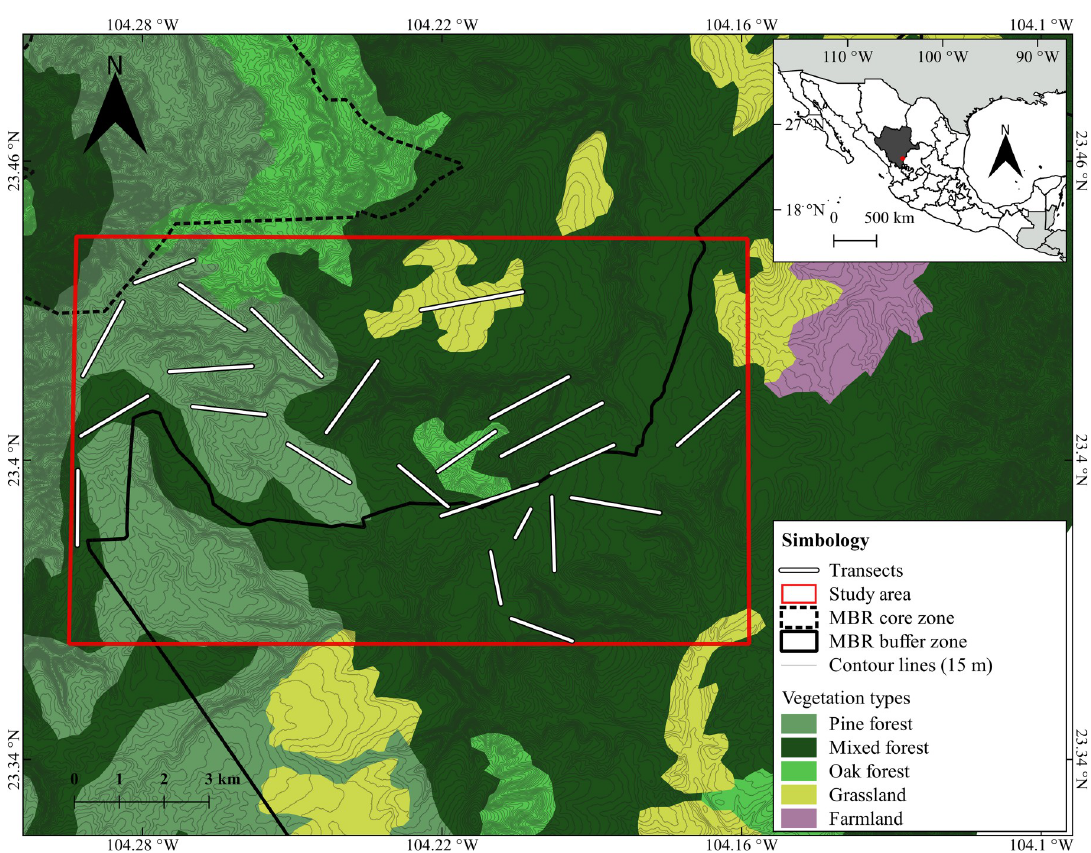
Fig 1. Geographic location of the study area in the buffer zone of La Michilı´a Biosphere Reserve (MBR), Durango, Mexico, showing the vegetation types and the location of the sampling transects. Fig 1 was created by CRRL (the first author) using freely available resources and software (see methods). Therefore, it is an original not copyrighted